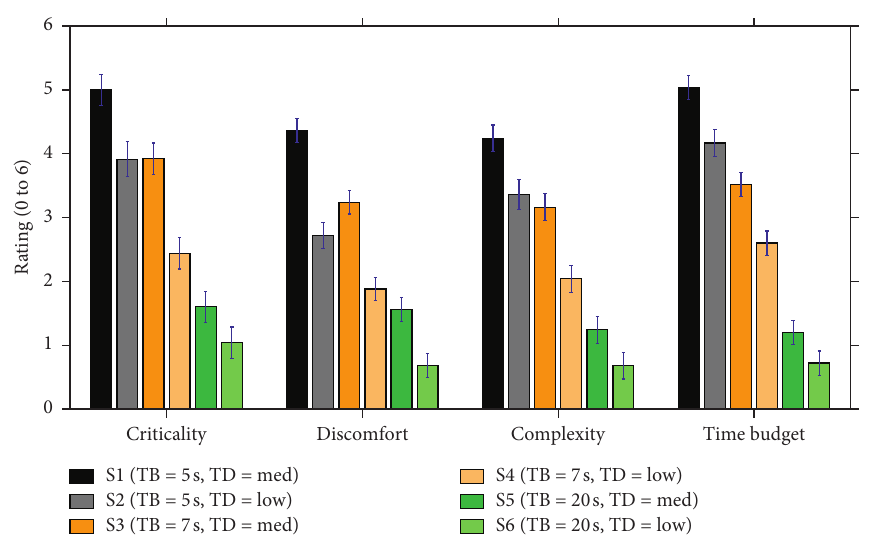
Figure 10: Mean of the subjective measures for the six scenarios. Error bars indicate standard